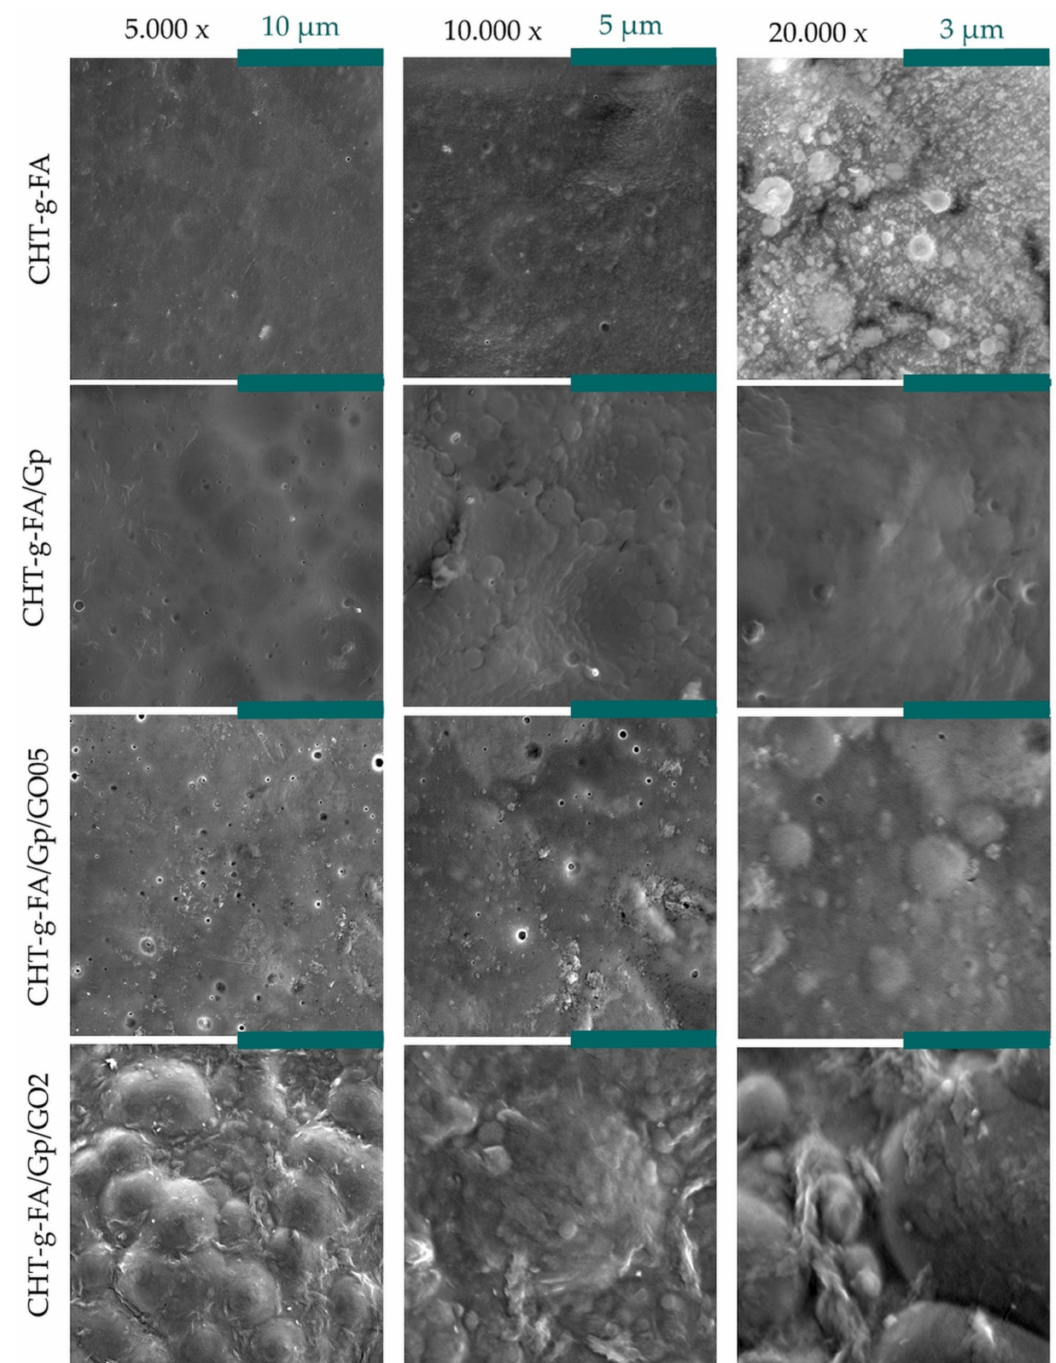
Figure 4. Surface morphology of the synthesized materials captured by means of